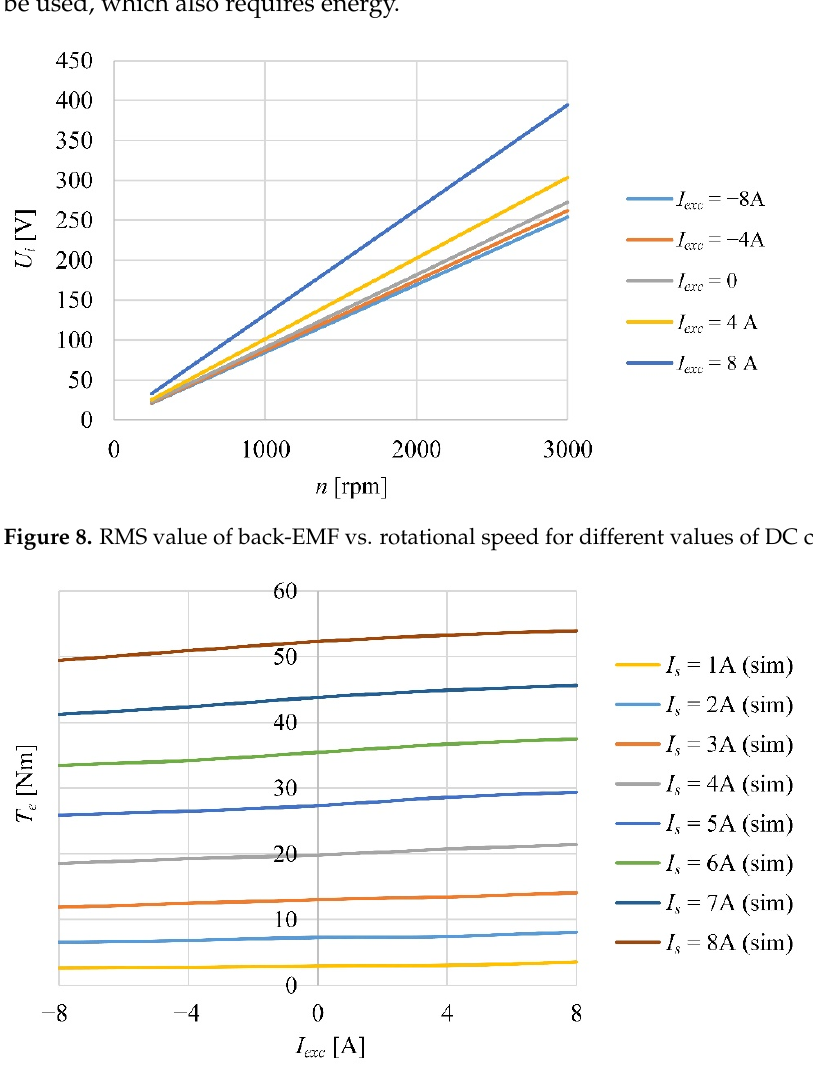
Figure 9. Electromagnetic torque with different currents in stator and DC coils.